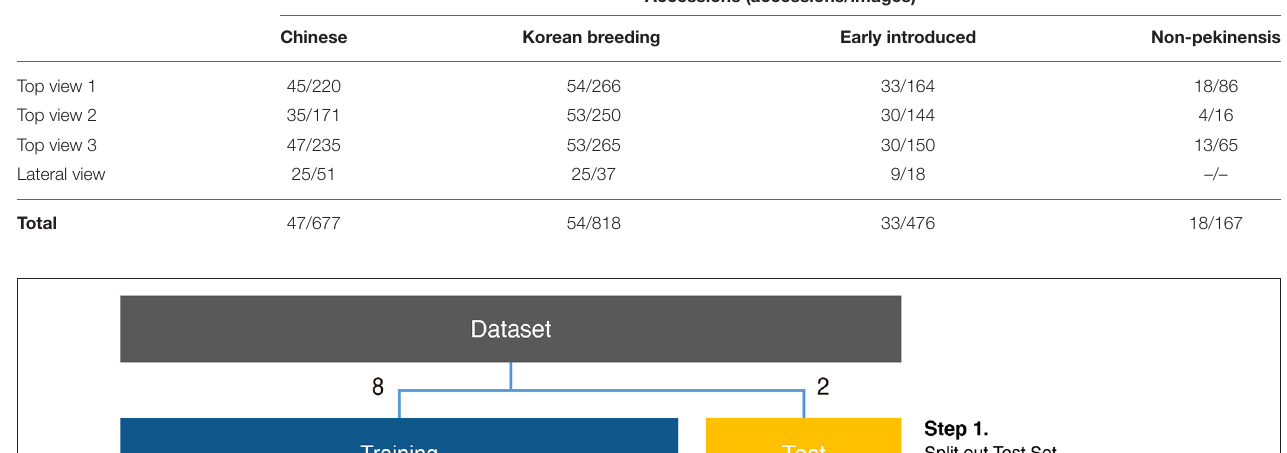
TABLE 1 | Datasets used for analysis.